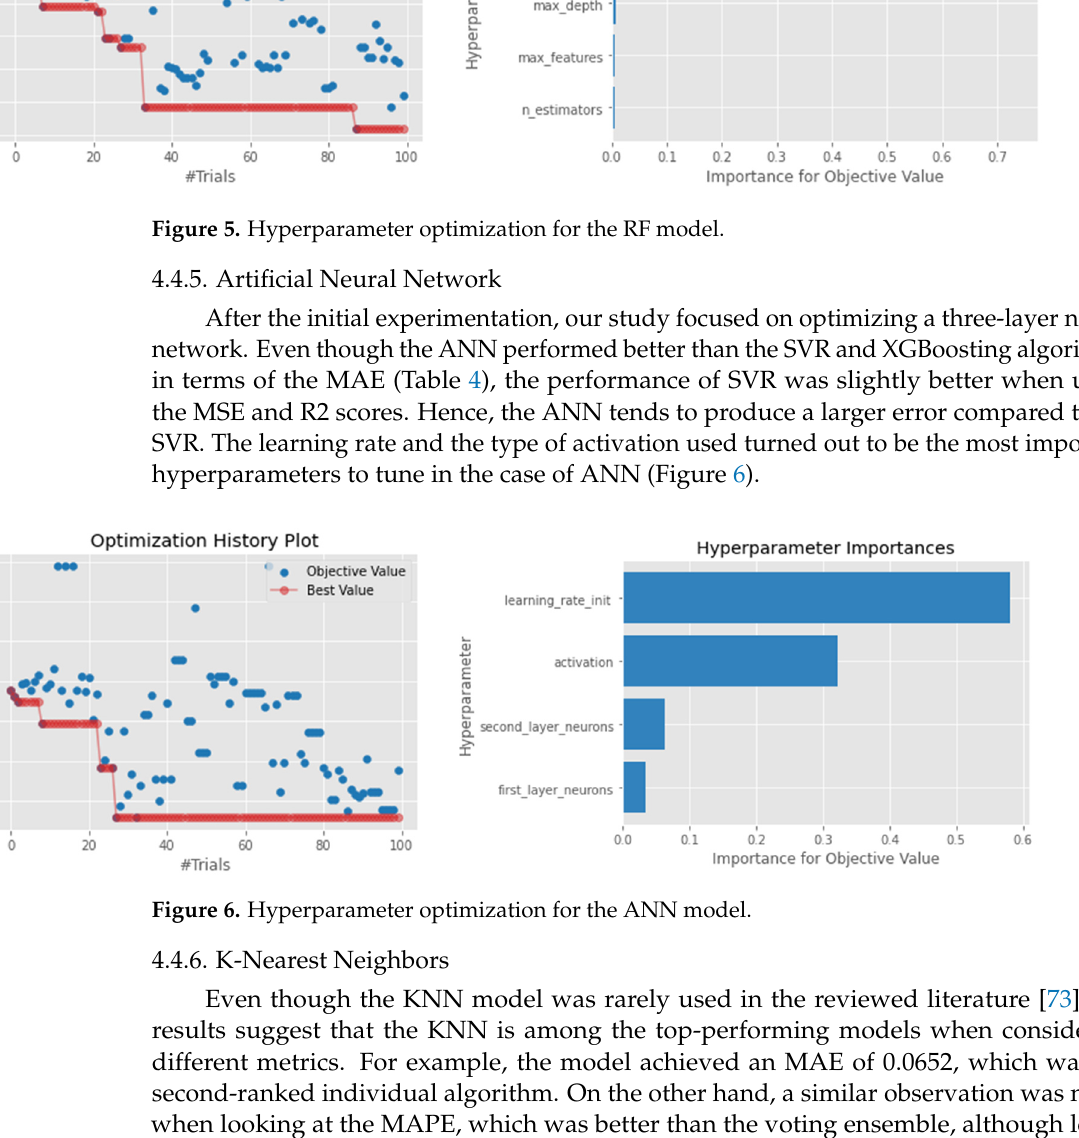
Figure 7. Hyperparameter optimization for the KNN model. 4.4.7. ExtraTrees (ETS) ETS differs from the RF model by randomly selecting features to perform the decision tree’s node split. This feature makes the ETS faster to train and, in some cases, achieve better results compared to the RF [74]. A similar pattern was observed in our study, where the ETS model outperformed the RF across several metrics. For example, looking at the MSE, ETS achieved a MSE of 0.0118 compared to the 0.0128 of RF. On the other hand, the R2 score value was also higher than that of SVR, RF, ANN, and XGBoosting, while match- ing the KNN and LightGBM, with a value of 0.7368. Similar to most tree-based ensembles, the number of features used to split the node and the minimum number of samples on the leaf node proved to be vital in optimizing the ETS model performance (Figure 8).